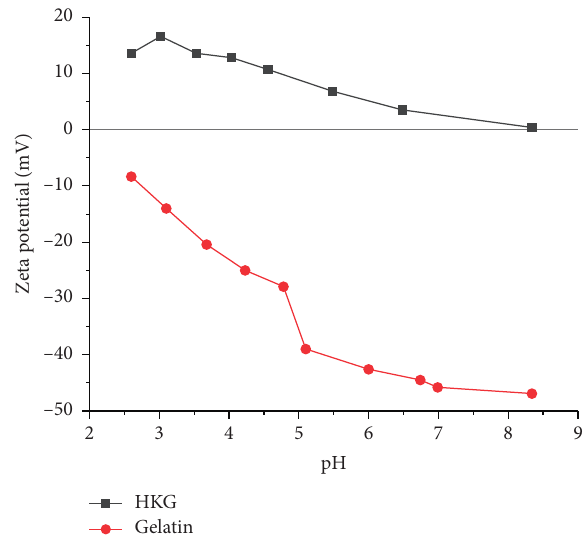
Figure 1: Zeta potentials of 0.1% gelatin and 0.1% HKG aqueous solutions at different